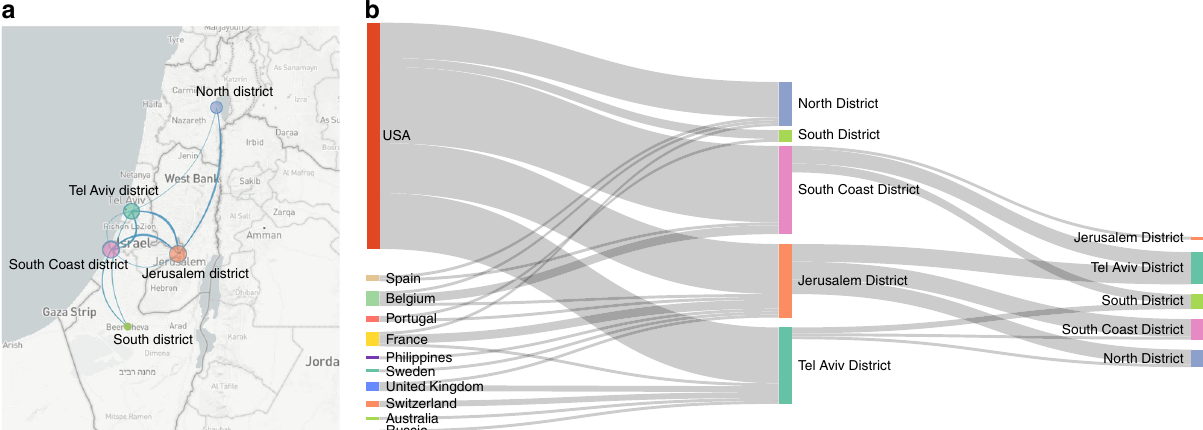
Fig. 4 Spread of SARS-CoV-2 into and within Israel. a Map of Israel with geographic locations of samples, and inferred spread inside Israel (blue lines). Figure generated using NextStrain 32 . b Inferred viral spread into and inside Israel, with directionality (left to right). Each line represents a transmission event inferred based on the phylogeny. Thicker lines indicate multiple transmission events. Source data are provided as a Source Data fi le.